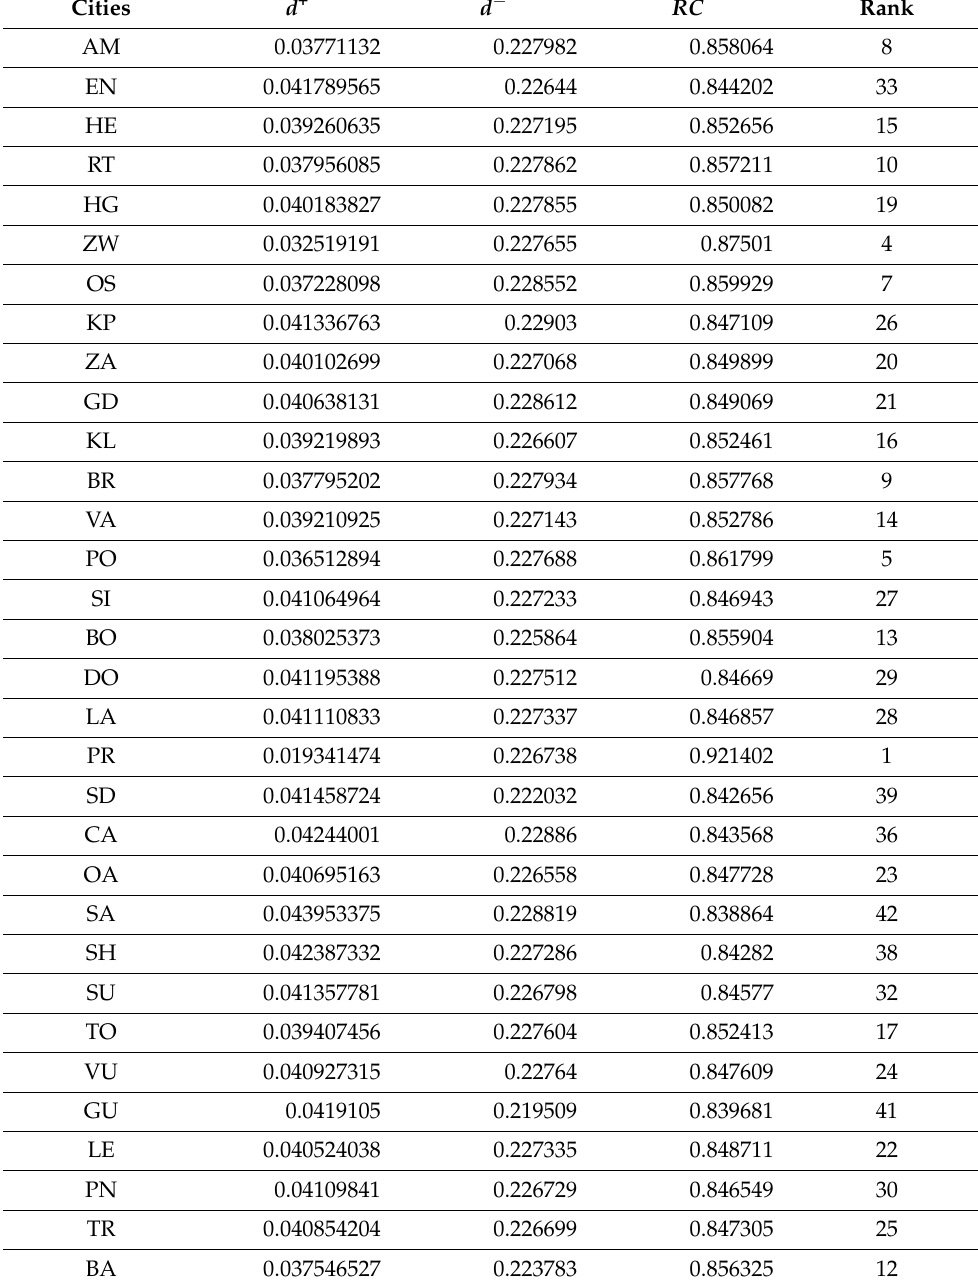
table. The values of the relative closeness coefficient range from 0.03504 to 0.921402. Table 6. The ranking of smart